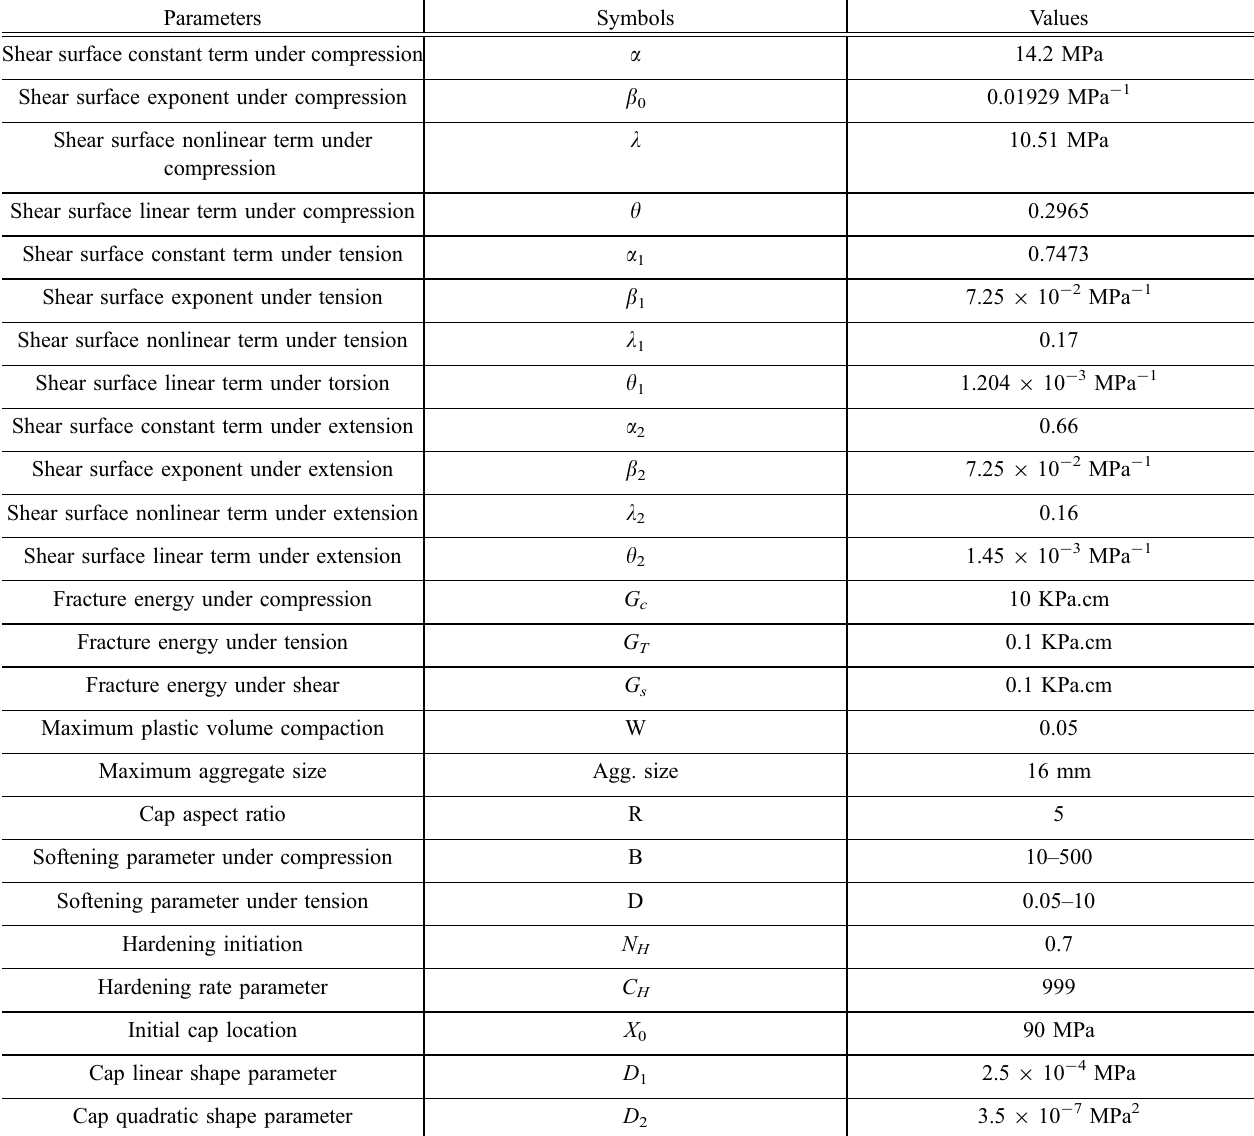
Table 1 The CSCM material parameters calibrated based on experimental data (Mousavi et al. 2016). Parameters